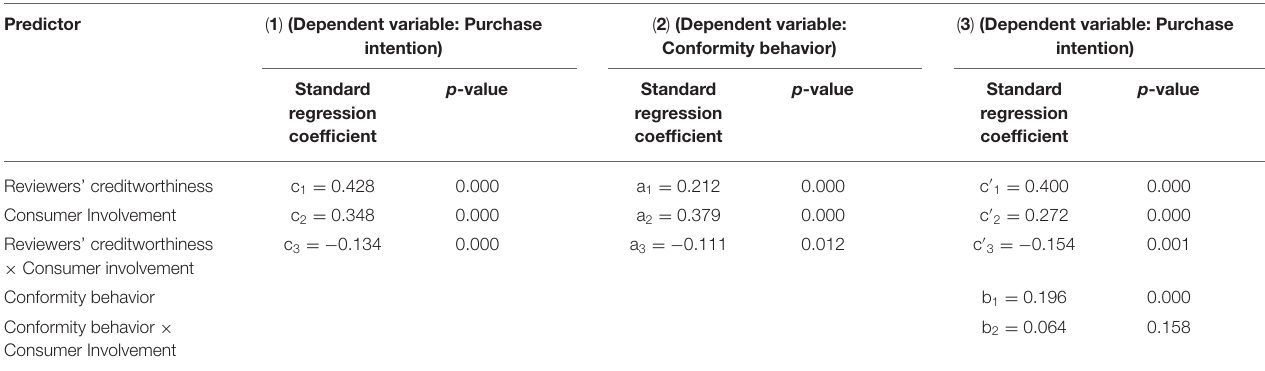
FIGURE 4 | Adjustment effect of mediation of consumer involvement. TABLE 4 | Results of intermediary effect